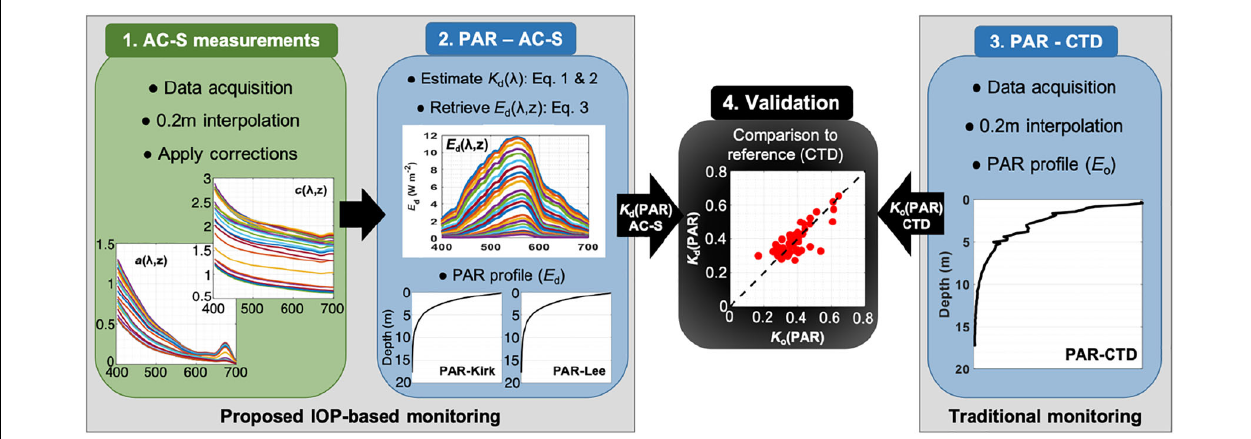
FIGURE 2 | Scheme showing the routine employed in this study. First, we retrieved the underwater light field and the diffuse attenuation coefficient for downwelling irradiance in the PAR range [ K d (PAR), 400–700 nm] from AC-S measurements with a spectrally resolved semi-analytical model. Then we calculate the scalar K o (PAR) from the light profile (reference observations). Finally, the AC-S based K d -values were validated against the reference K o